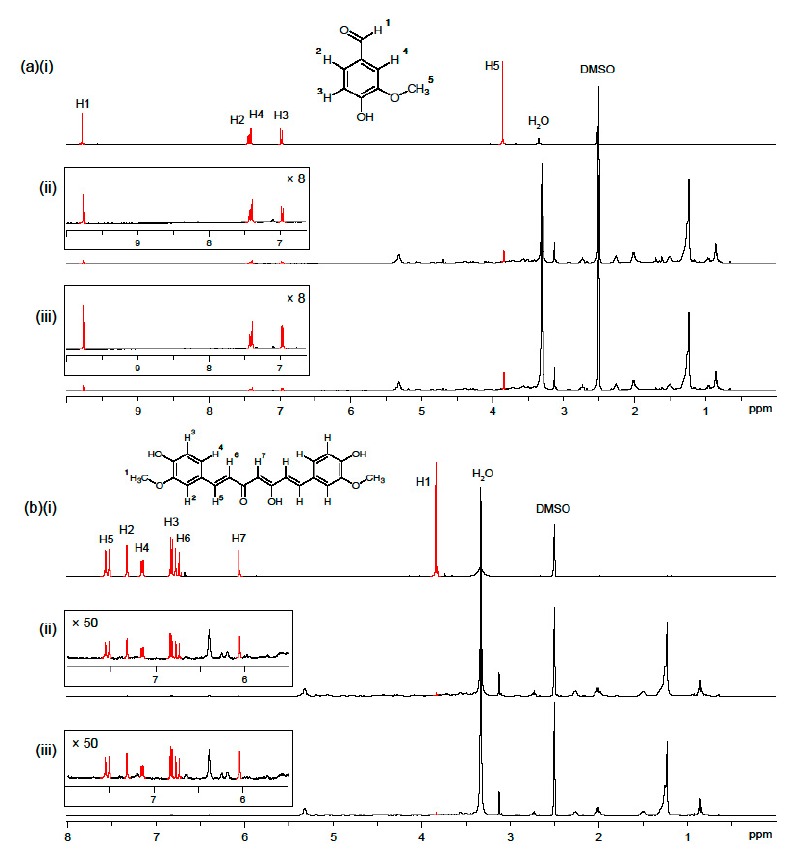
Figure 5. 1 H-NMR spectra (298 K, 400 MHz) in DMSO- d 6 of vanillin ( a (i)) and curcumin ( b (i)); and electrospun phospholipid fibers with encapsulated vanillin and curcumin analyzed at different storage times: (ii) 1 day and (iii) 30 days.